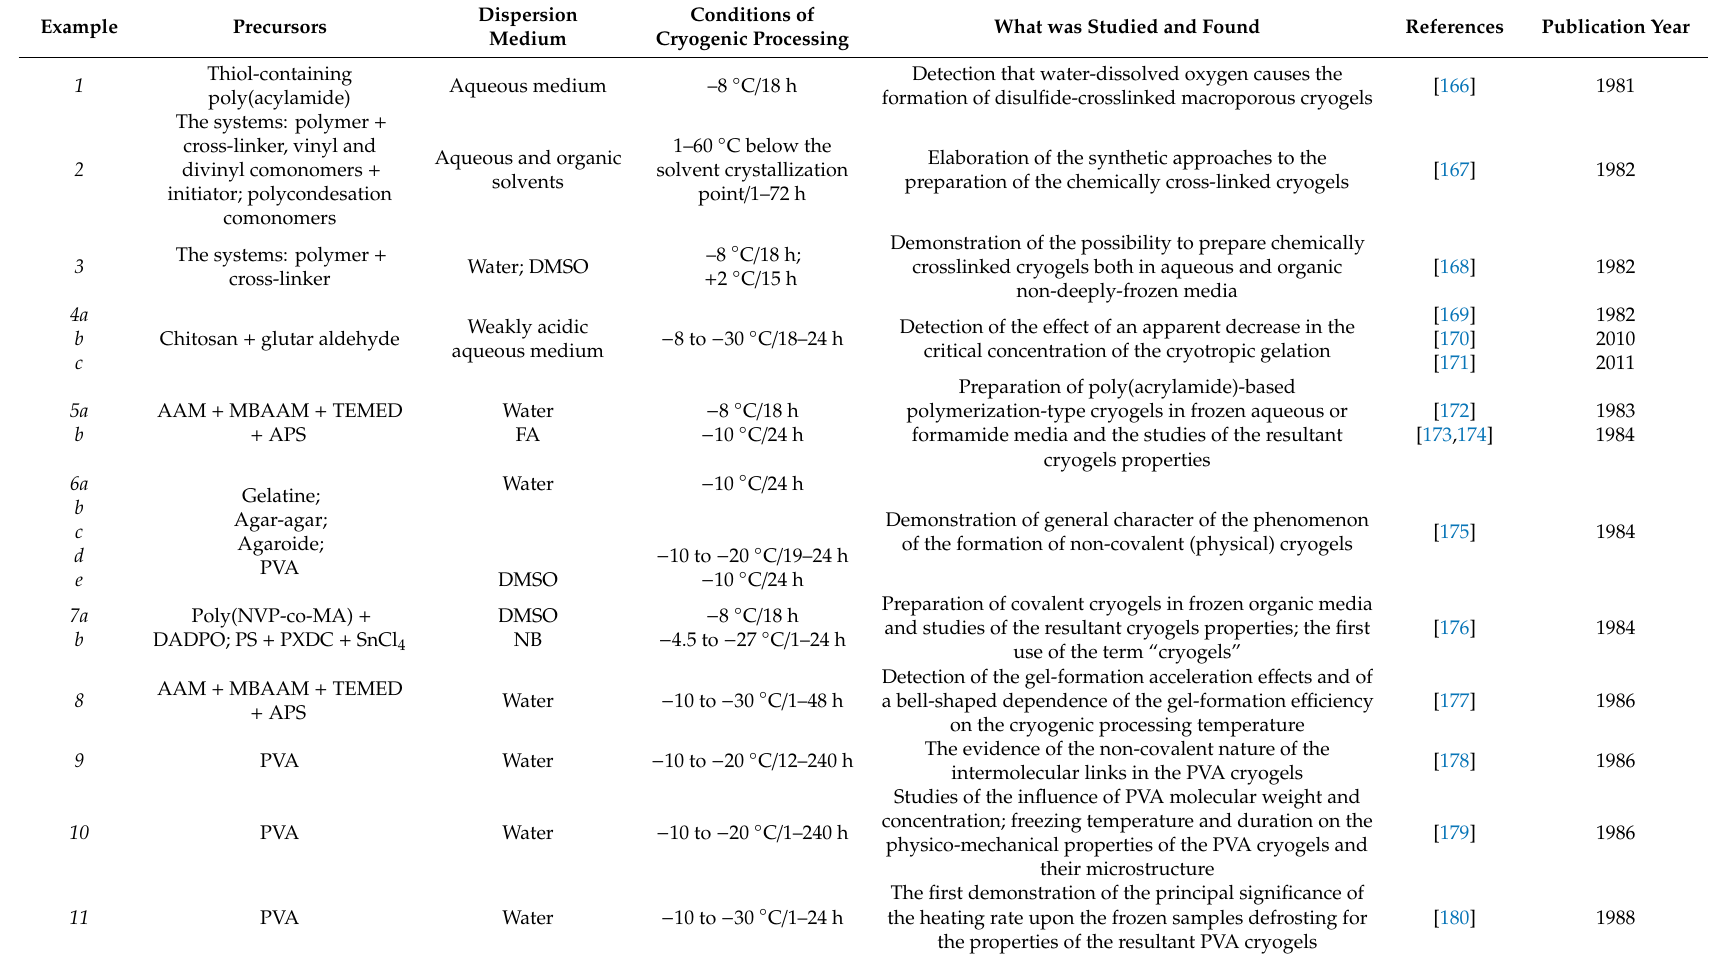
Table 1. Basic research performed in the IOEC in the frameworks of the topics related to the cryogenic structuring